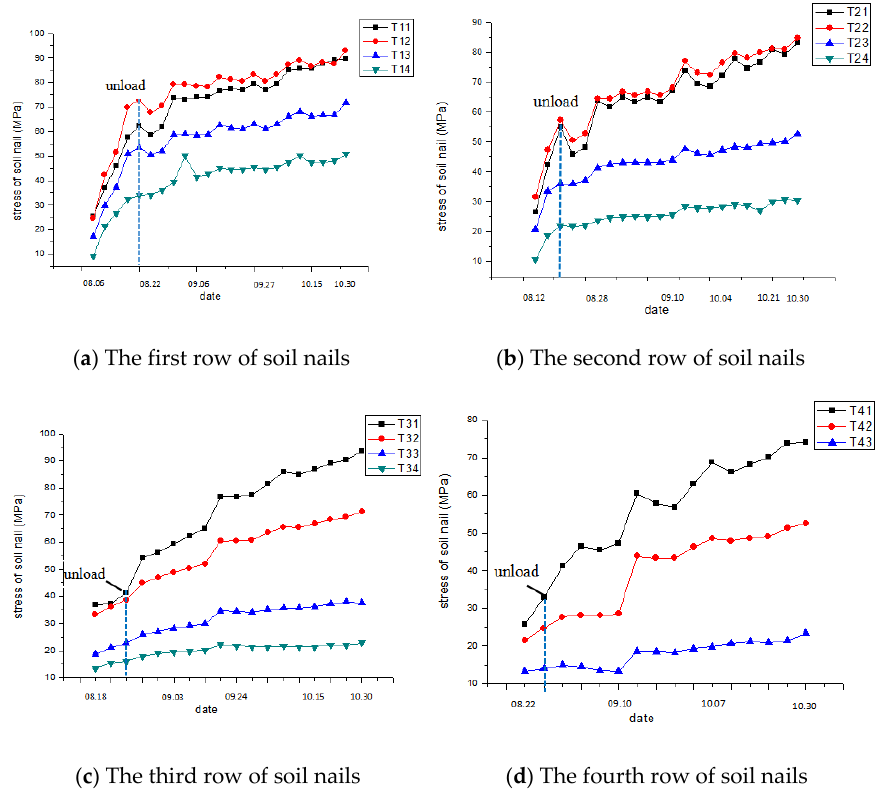
Figure 12. The influence of unloading on stress of soil nails for section No.1.